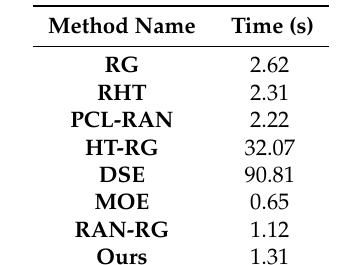
Table 3. Execution time for icosahedron.